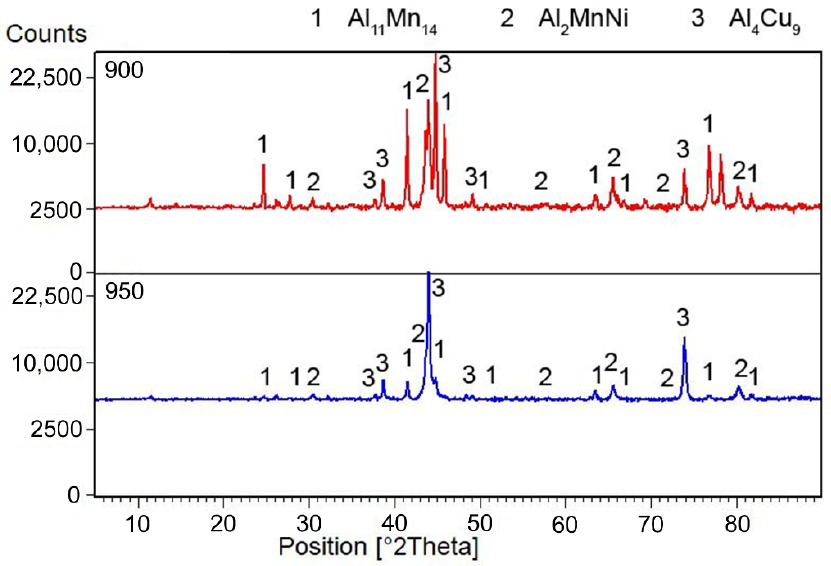
Figure 7. X-ray diffraction pattern of a metal sample sintered at 900 and 950 °C.